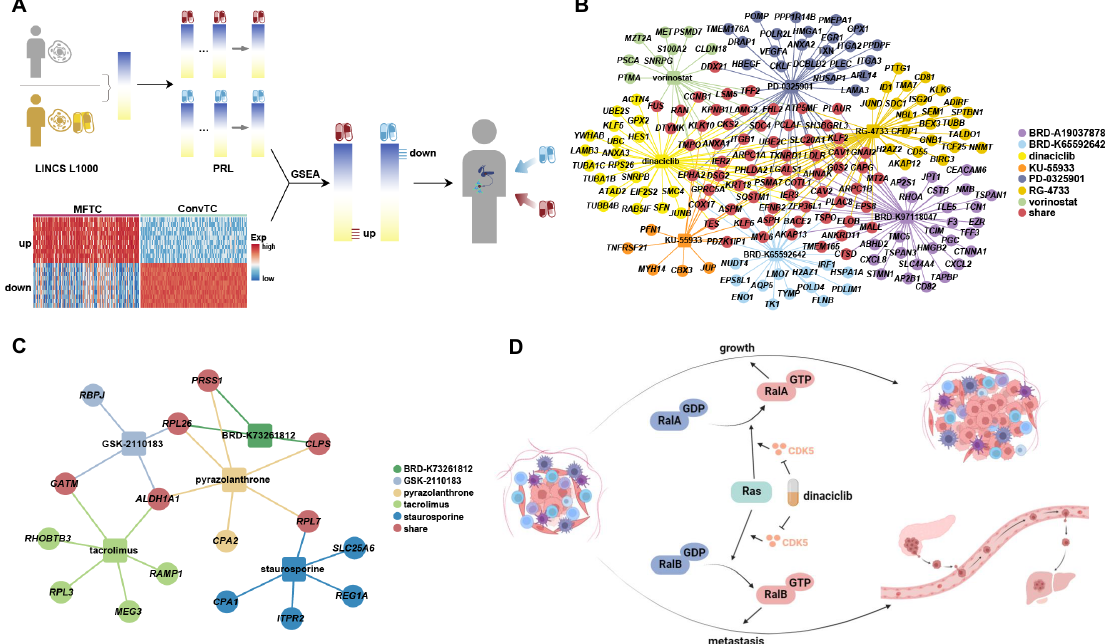
Figure 6. Drug prediction based on metastatic signature genes (MSGs). ( A ) Workflow of drug prediction. ( B , C ) Network of genes regulated by each drug. Drugs regulating the top 10% of genes from up- ( B ) or down-regulated ( C ) MSGs are displayed. Rectangles indicate drugs, and circles indicate genes. Each line and node color indicates one drug. If a gene could be regulated by more than one drug, the node is colored red. ( D ) Depiction of the regulation of cyclin-dependent kinase 5 (CDK5) by dinaciclib in tumor growth and metastasis. Created with BioRender.com on 2 September